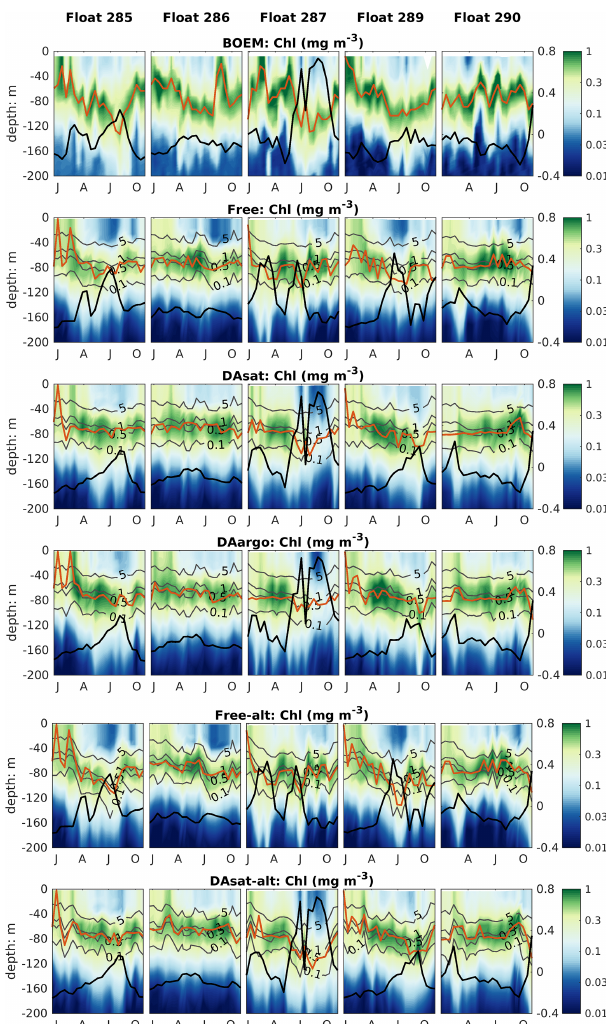
Figure 8. Same as Fig. 4 but for chlorophyll. Gray contours repre- sent the simulated isolumes, and red lines represent the depth of the deep chlorophyll maximum. Thick black lines represent